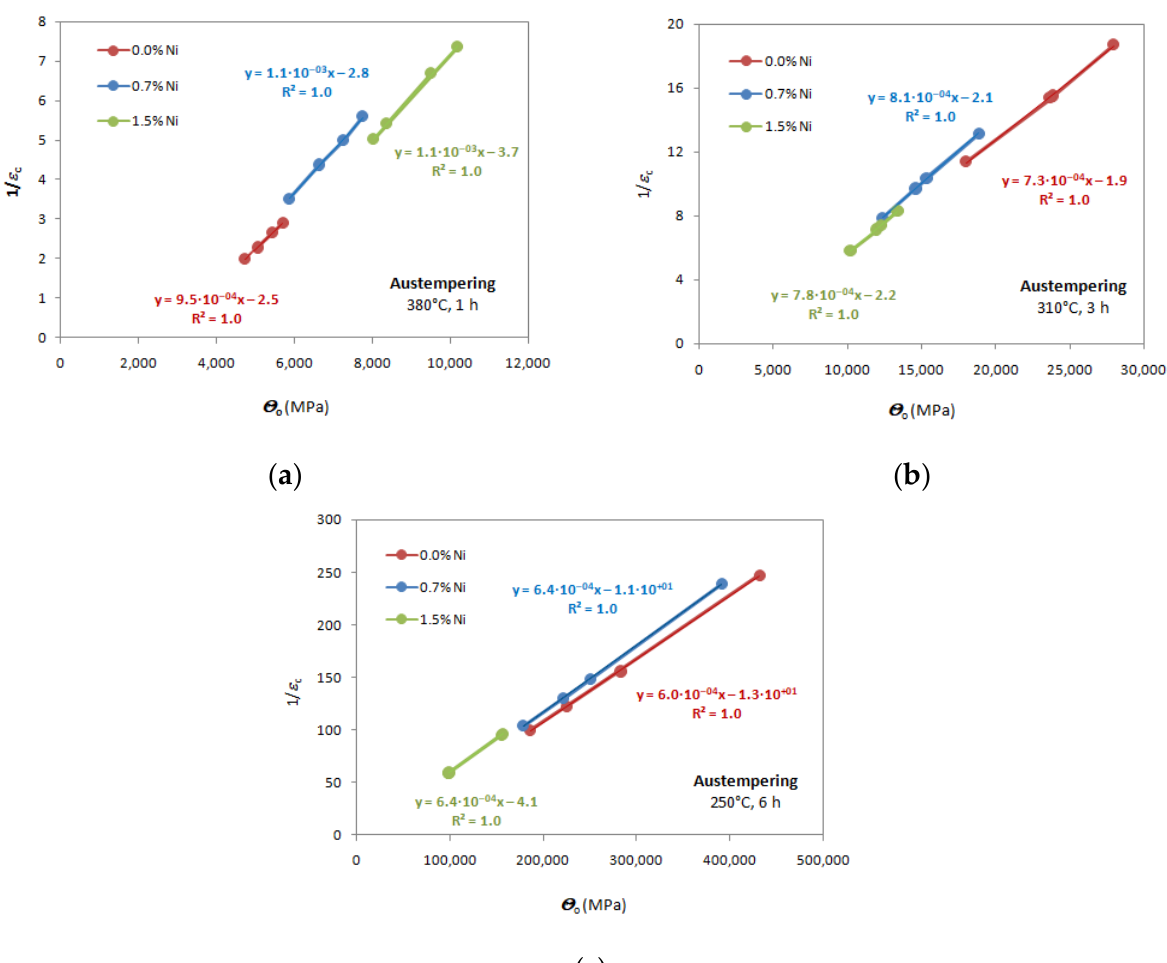
Figure 12. Matrix Assessment Diagrams (MAD) for round tensile specimens from 25 mm Y-block ADIs of three nominal Ni contents (0.0, 0.7 and 1.5 wt%) and different austempering conditions: ( a ) 380 °C for 1h; ( b ) 310 °C for 3 h; ( c ) 250 °C for 6h.